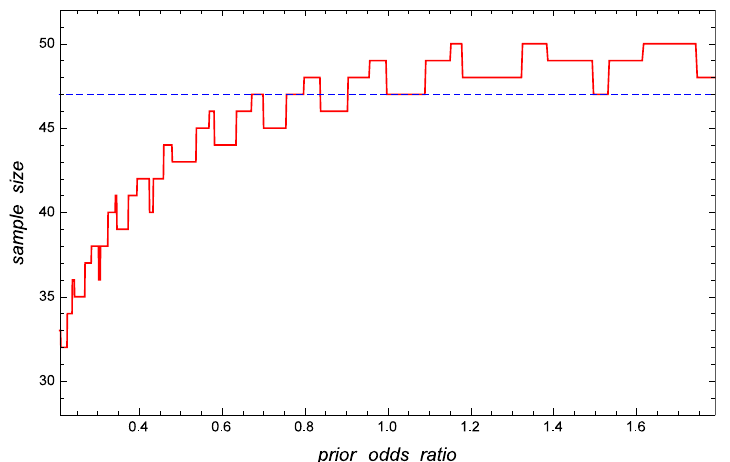
Figure 3. Optimal Bayesian ( solid line ) and frequentist ( dashed line ) sample sizes, n ∗ and n f , versus the prior odds ratio when µ 0 = 0.35, µ 1 = 0.65, d 0 = d 1 = 1, α = 0.05 and β =